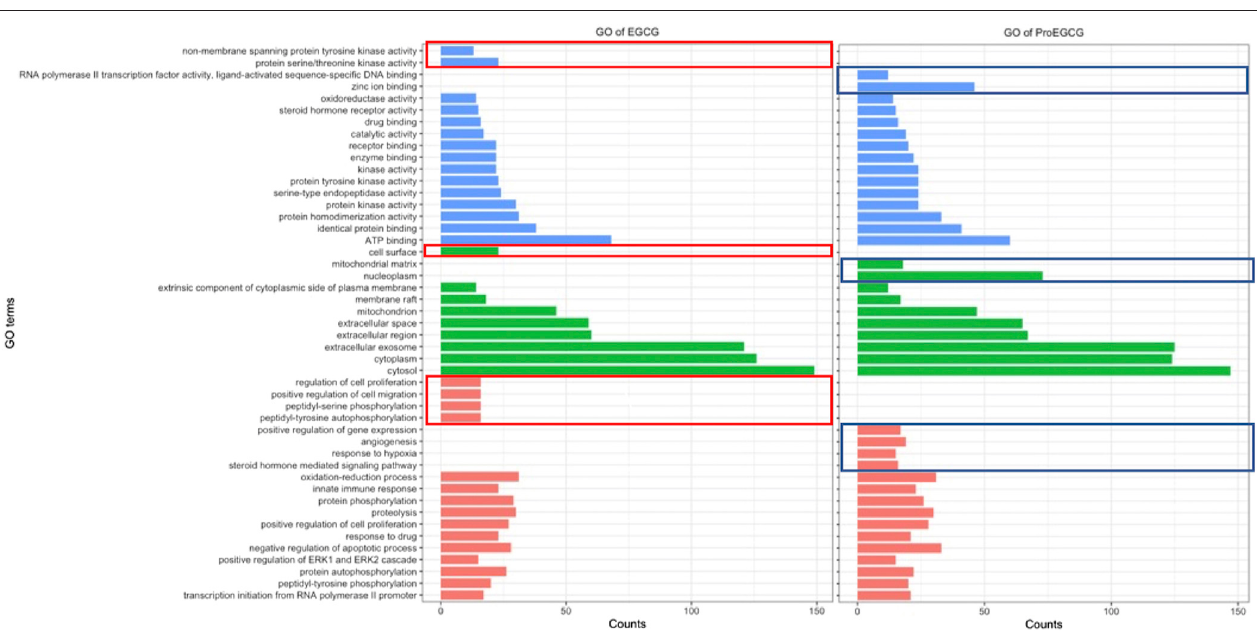
FIGURE 2 | GO functions EGCG (left) and ProEGCG (right) . Differential functions of EGCG and ProEGCG were highlighted in red (EGCG) or blue (ProEGCG).